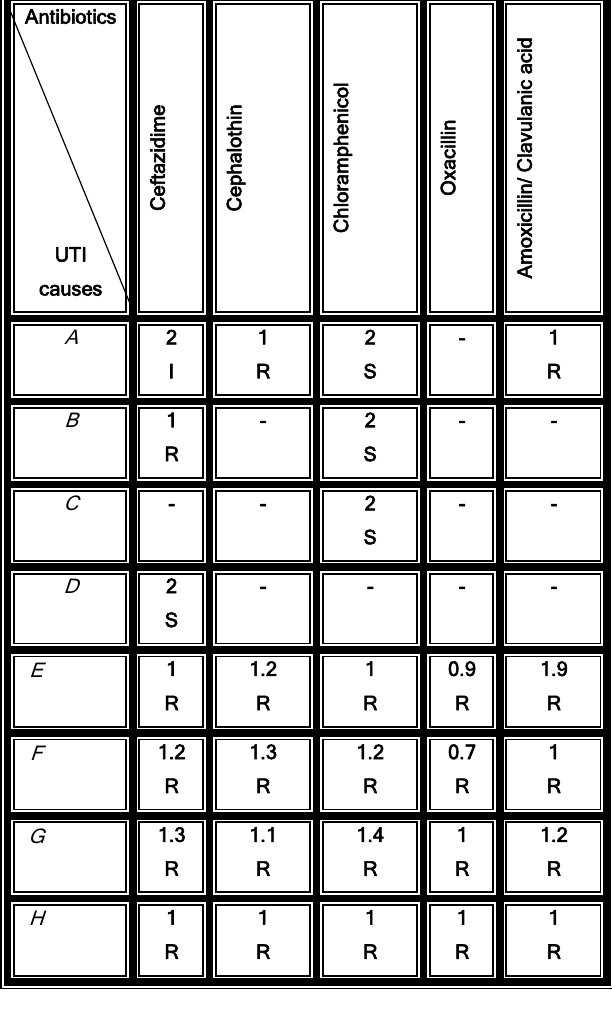
Table (1) Inhibition zones ofantibiotics by